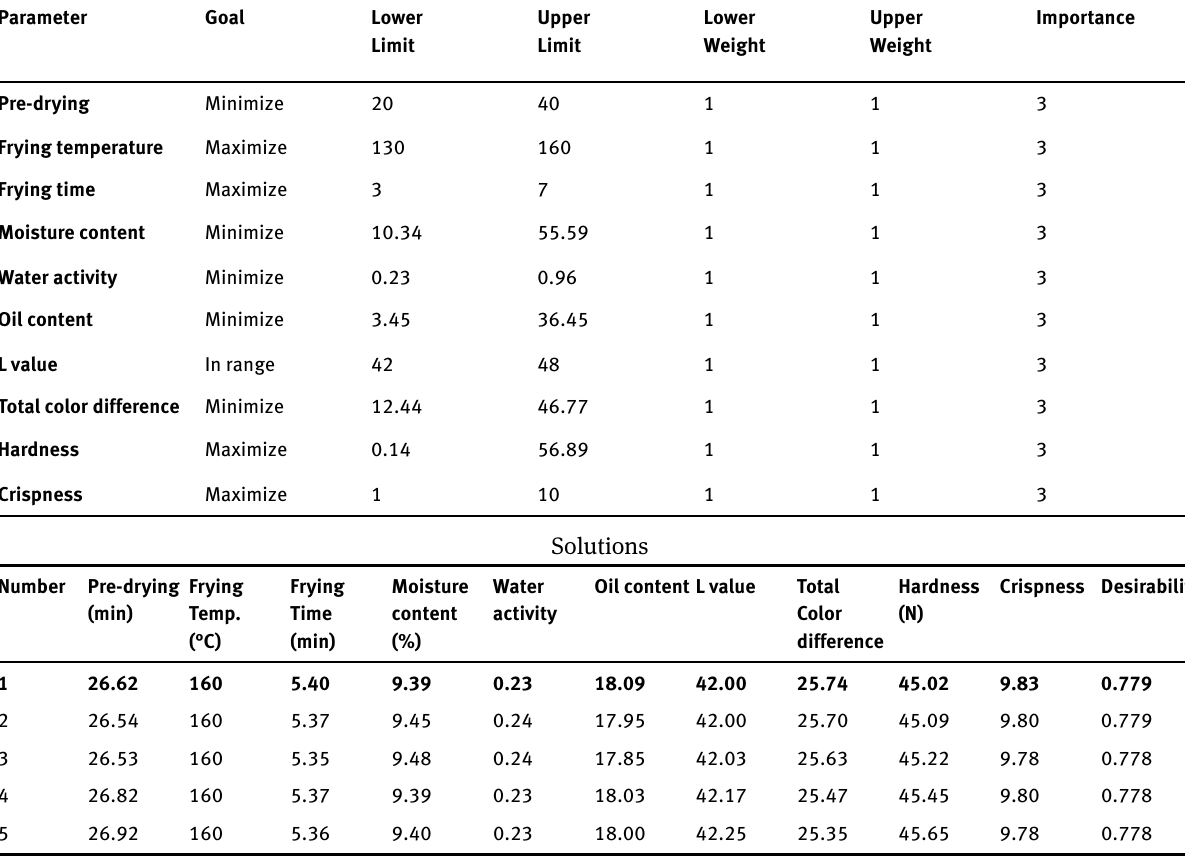
Table 4 : Results of numerical optimization using desirability function of sweet potato chips